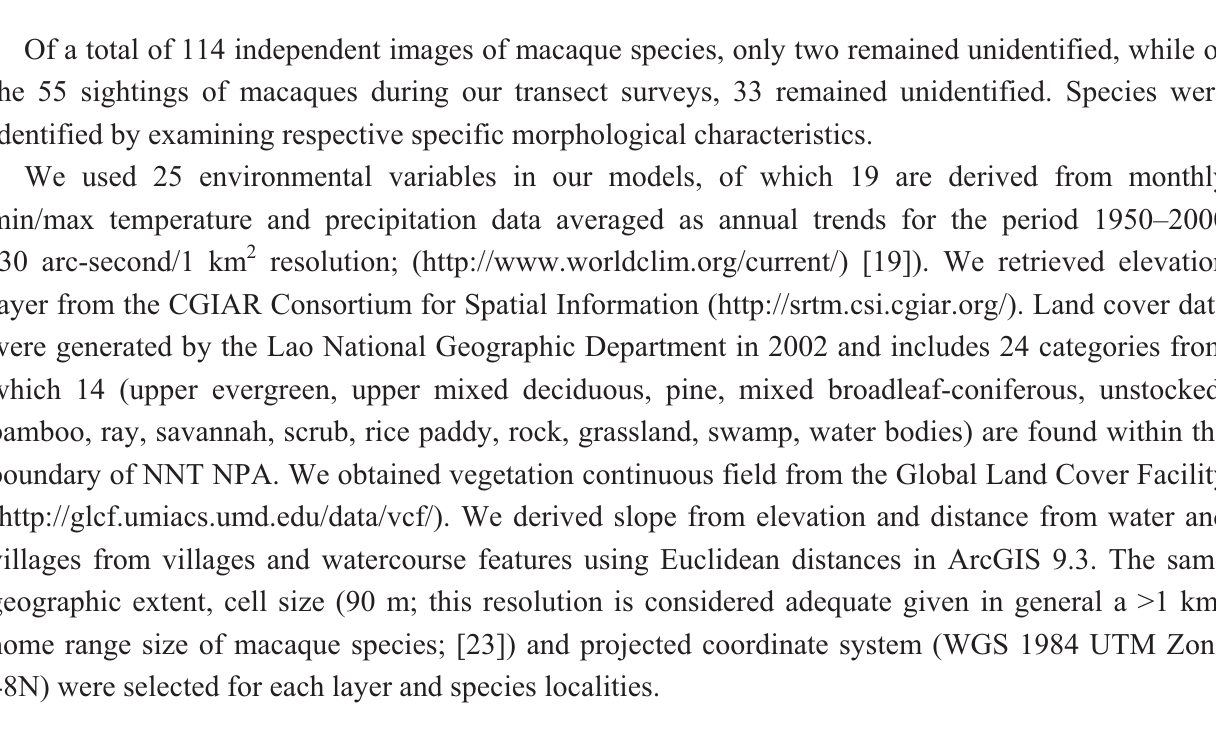
Table 2. Occurrence from camera-trap and transect survey data used for the distribution modelling of each species. Occurrence from Occurrence from Species camera-trap confirmed